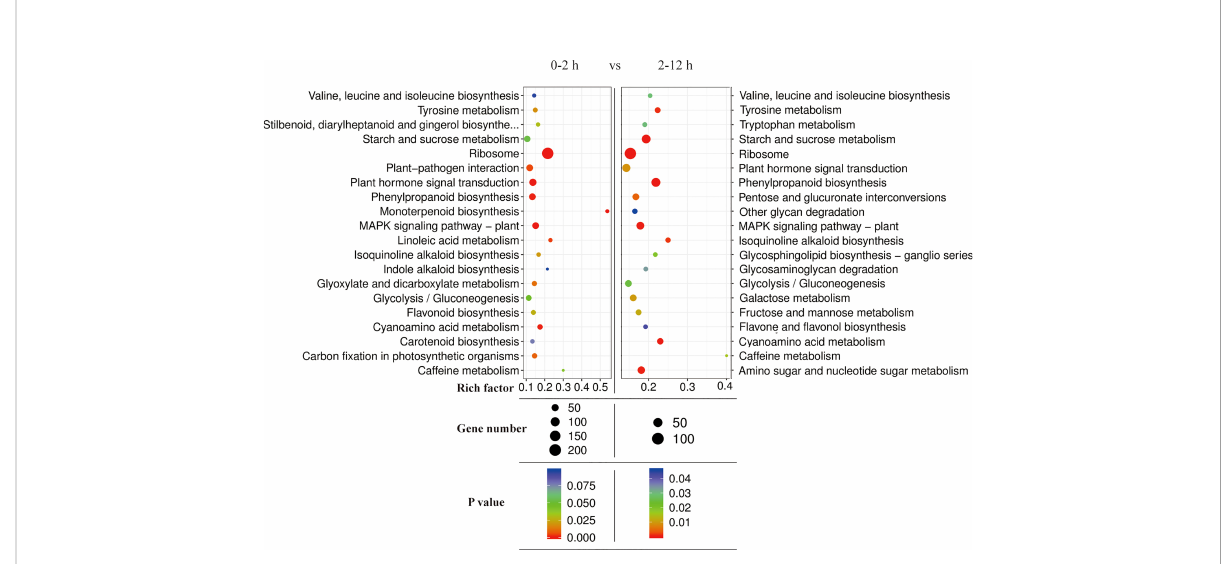
FIGURE 9 KEGG enrichment analysis of DEGs of two different periods (0-2 h and 2-12 h) during salt